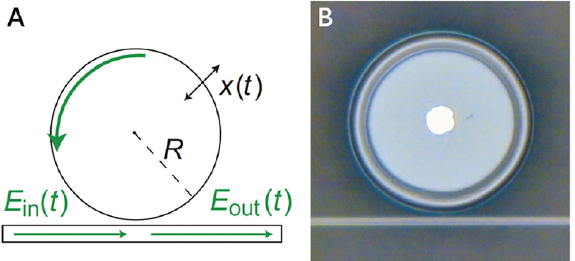
Figure 5: Motion transduction with a microtoroid cavity. (A) Schematic and (B) optical microscope image of tapered fiber coupled microtoroid cavity [31].